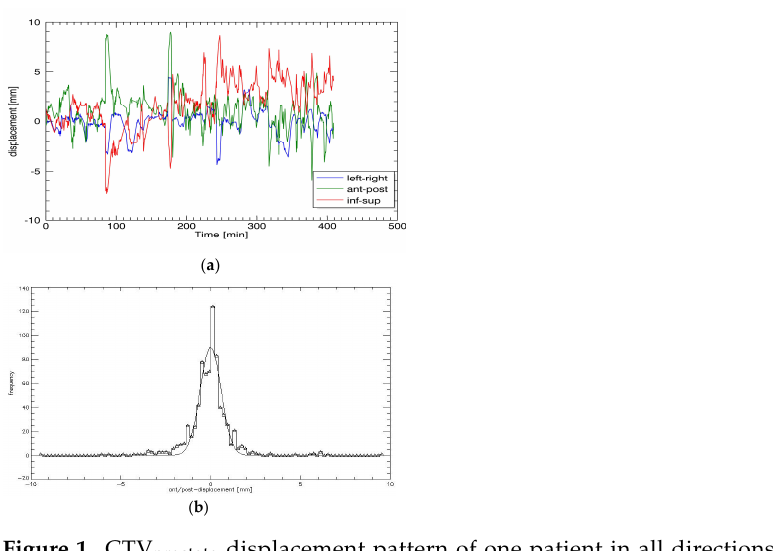
Table 1. Proportionality constants that correspond to a certain coverage of the PTV.